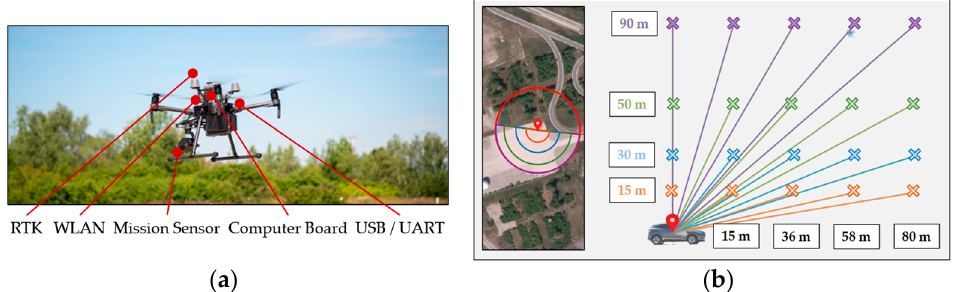
Figure 6. Real fl ight setup for data acquisition: ( a ) Hardware con fi guration of the multicopter system used with the corresponding extensions; ( b ) Semi-circular fl ight pa tt ern to capture the di ff erent ob- used with the corresponding extensions; ( b ) Semi-circular flight pattern to capture the different object ject views. Di ff erent gradations of fl ight altitude and distance to the object also generate a variation views. Different gradations of flight altitude and distance to the object also generate a variation in in relation to the angle of view. relation to the angle of